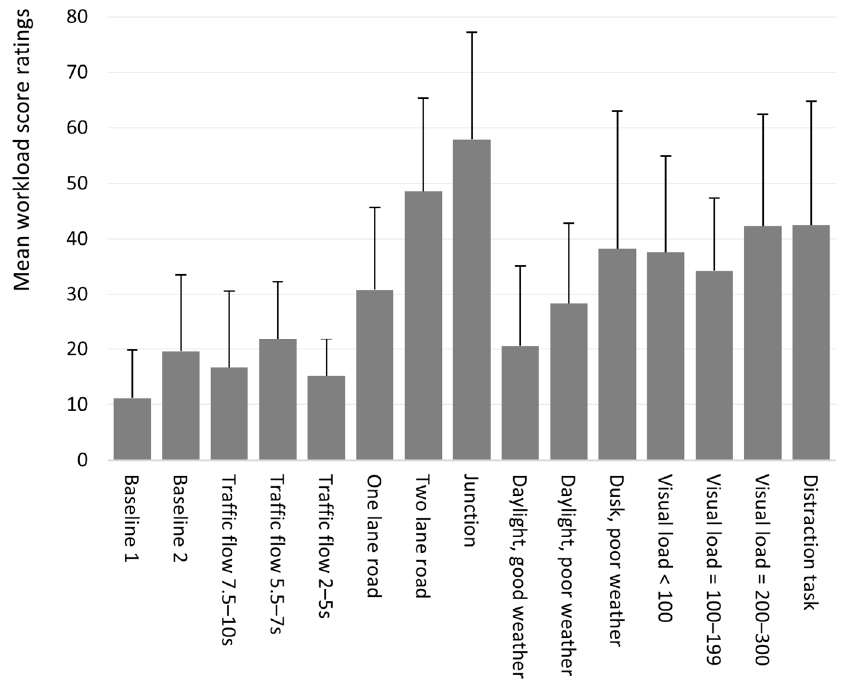
Figure 7. Mean workload score ratings for each scenario. Error bars indicate standard deviations.